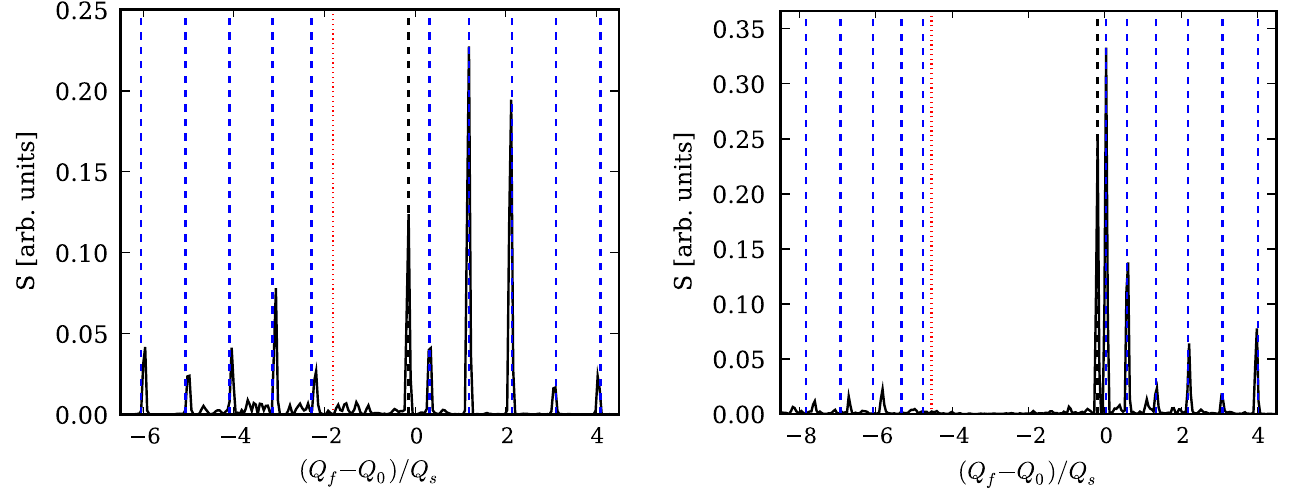
FIG. 4. (Color) Simulation noise spectrum for an airbag distri- bution in a square well potential and (cid:1) Q sc =Q s ¼ 2 . The dashed blue and black ( k ¼ 0 ) lines indicate the analytic results from Eq. (8). The dotted red line represents the incoherent space charge tune shift (cid:1) Q sc .